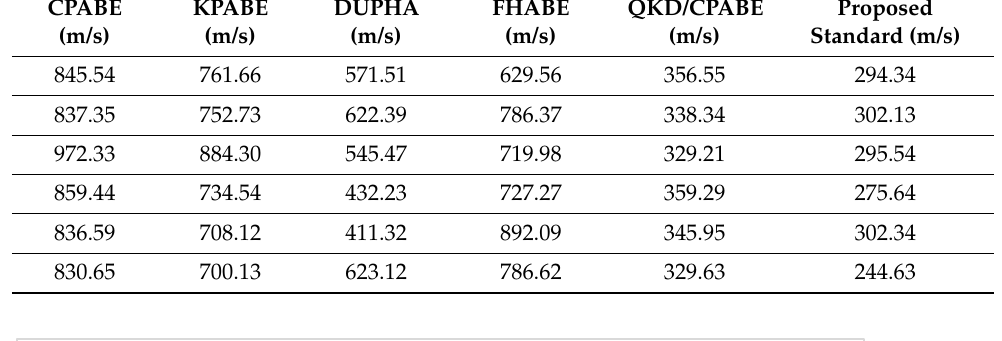
Figure 5 exemplifies the comparative analysis of various Hash ‐ based Encryption Techniques with the proposed one.